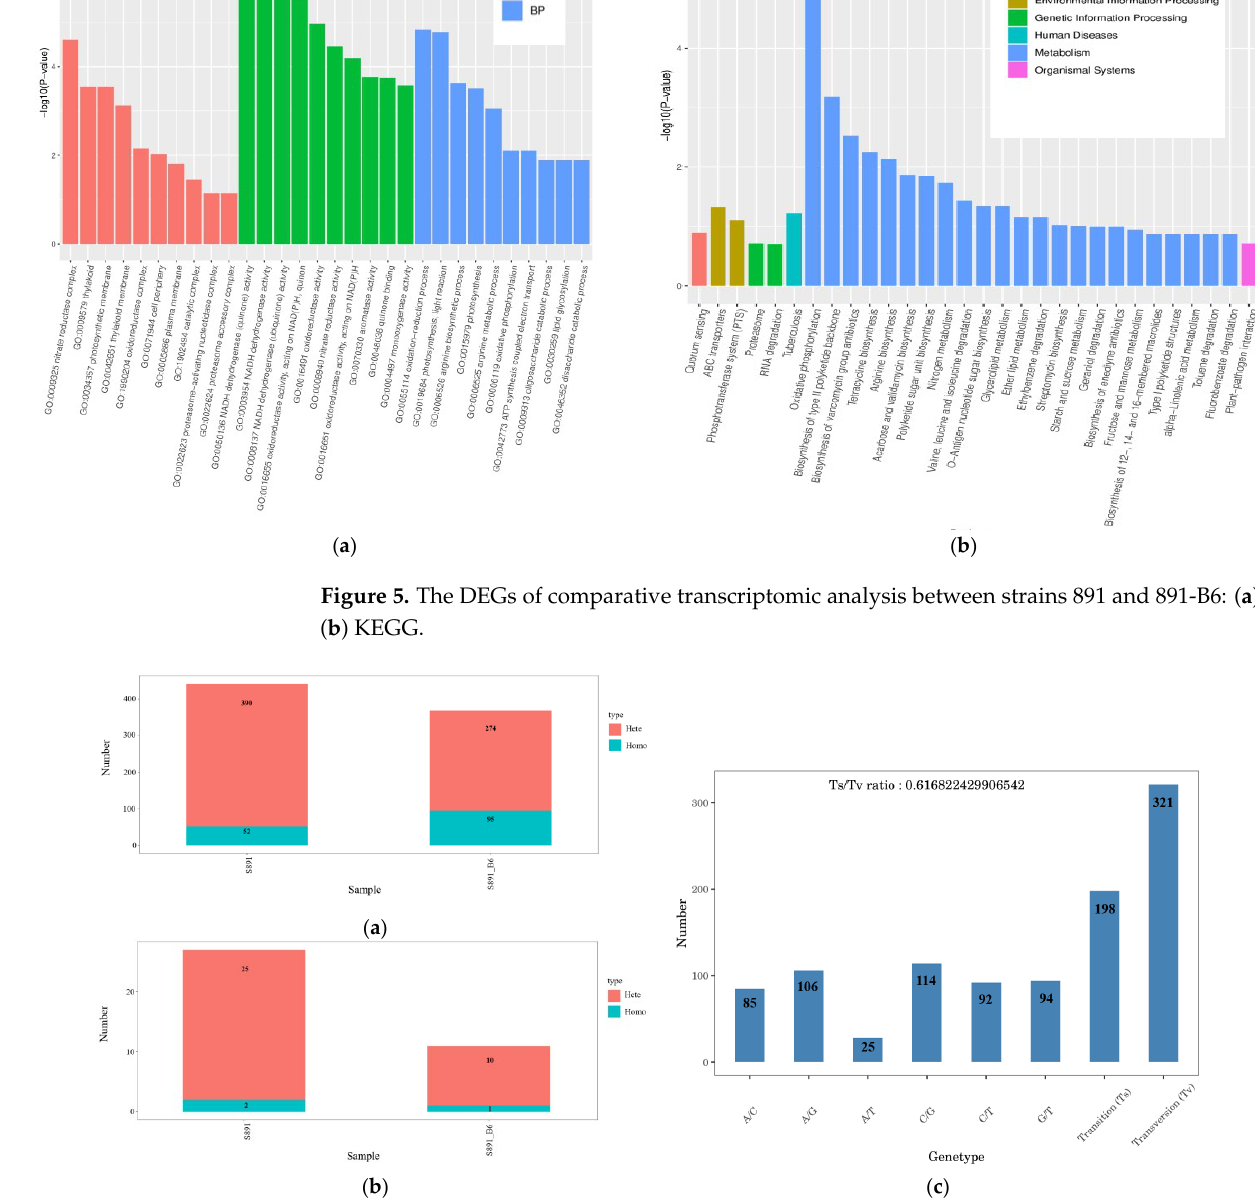
Figure 6. The SNPs ( a ) and InDels ( b ) results for strains 891 and 891-B6; ( c ) transition and transversion